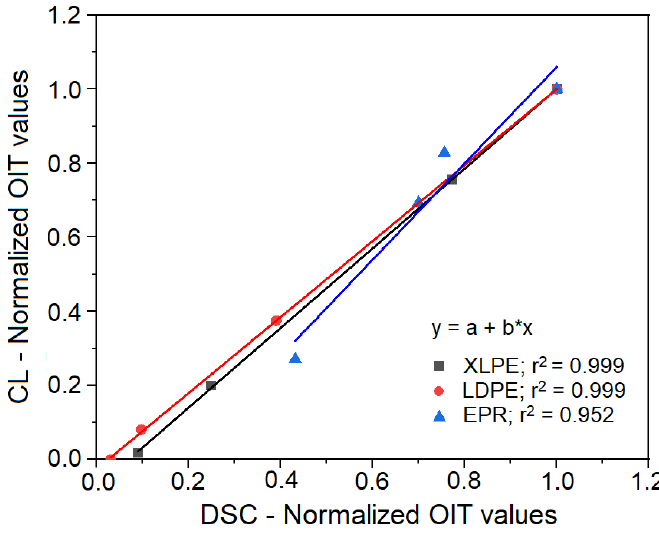
Figure 14. DSC — CL OIT correlation. Figure 14. DSC—CL OIT